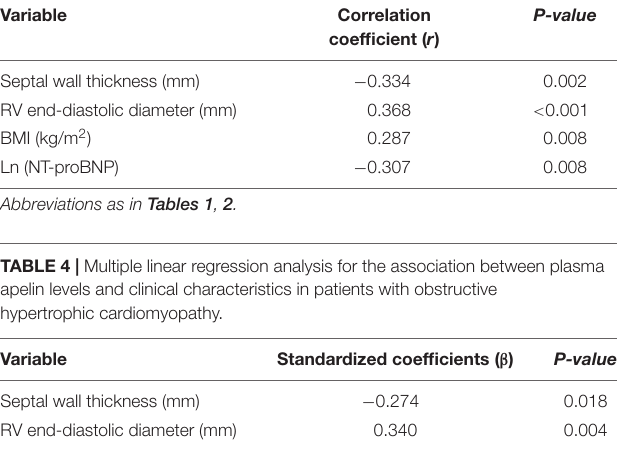
Patients with lower apelin levels (plasma apelin ≤ 96.6 µ g/L) had greater septal wall thickness than those with higher apelin levels (plasma apelin > 96.6 µ g/L; 25.6 ± 5.5 vs. 23.2 ± 4.3